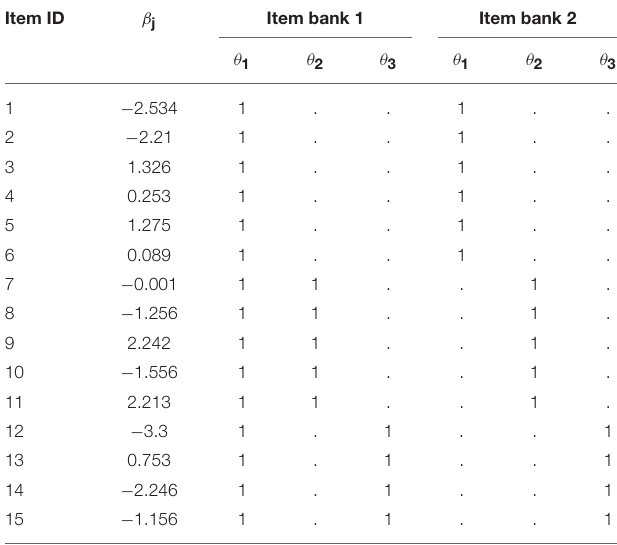
TABLE 1 | Patterns of multidimensionality (a sample of 15 items from two item